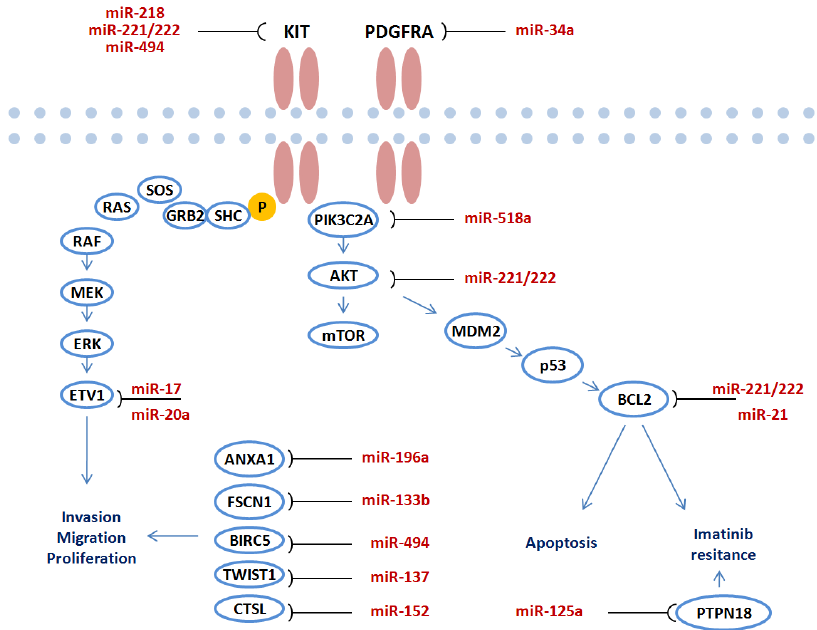
Figure 2. Functional role of deregulated miRNAs in GIST carcinogenesis. miRNAs regulate target gene expression and mediate invasion, migration, proliferation, apoptosis and imatinib resistance through key molecular pathways.